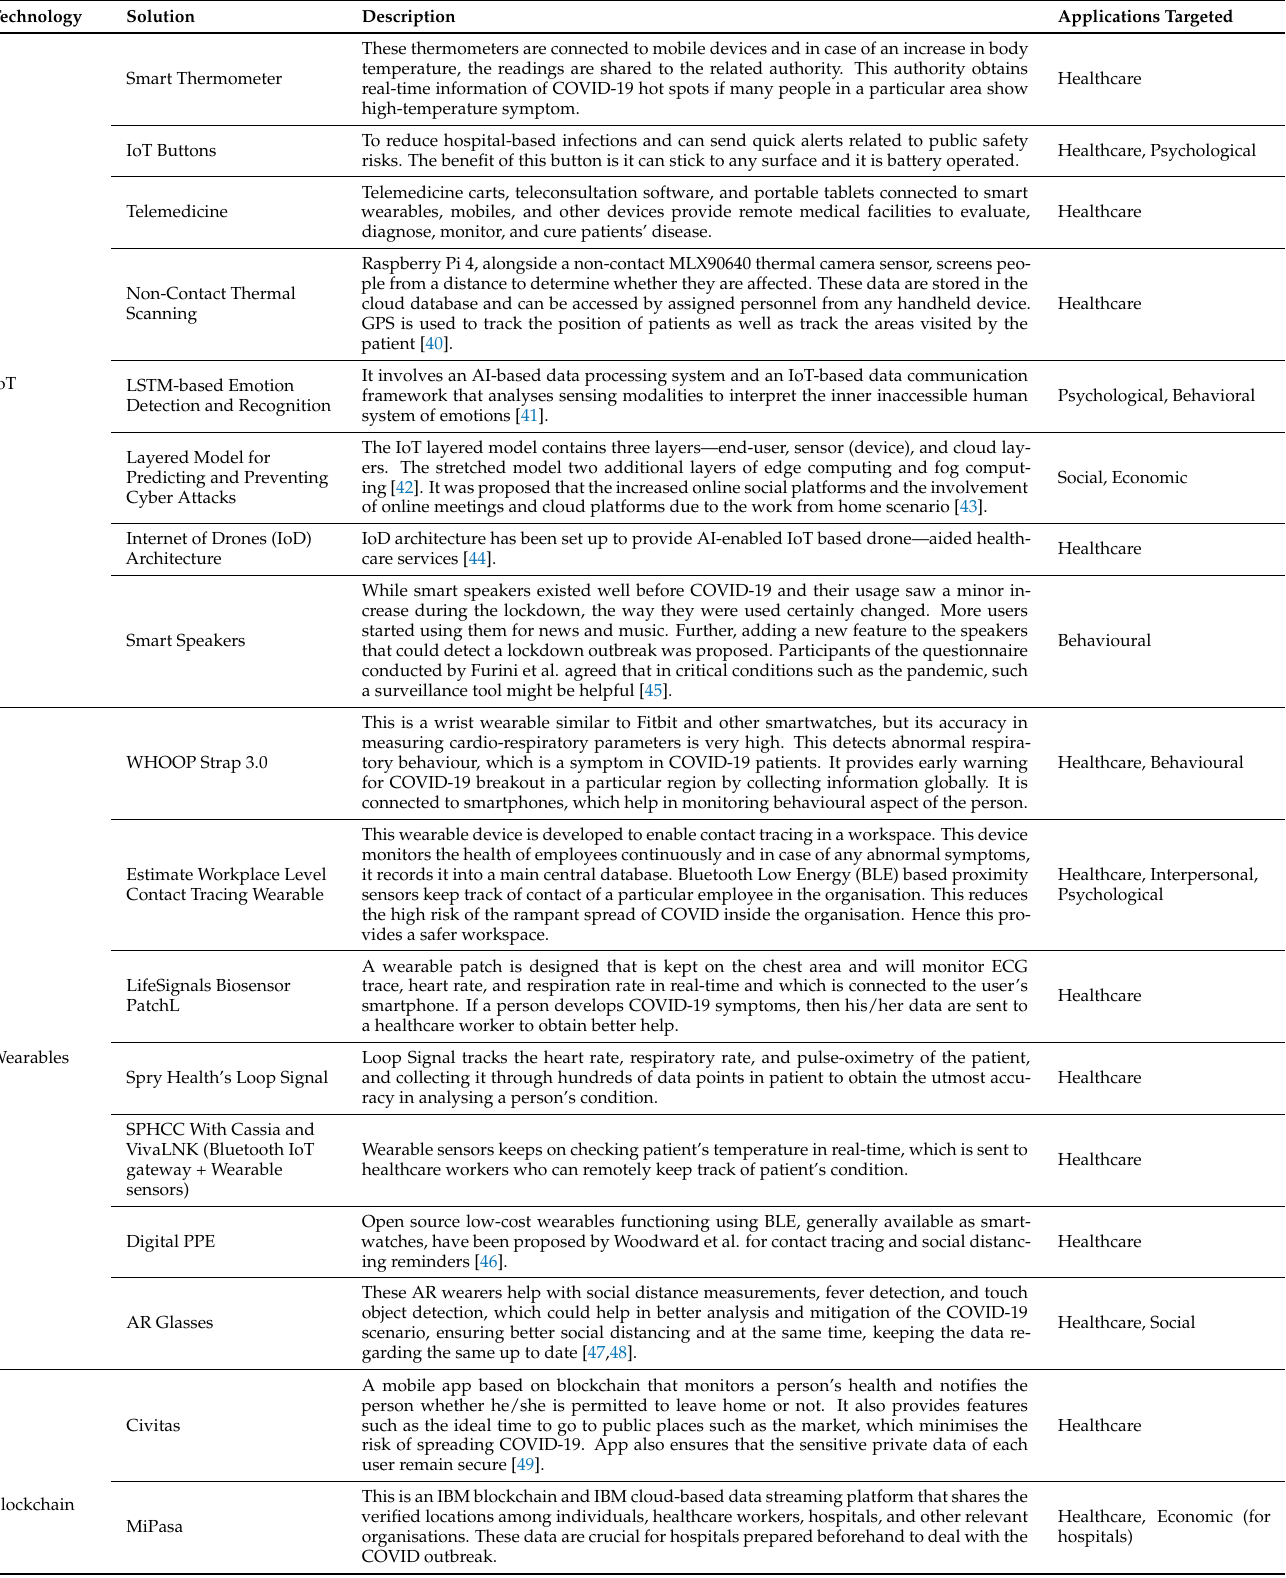
Table 5. Present technological solutions to mitigate negative impacts of COVID-19 on human